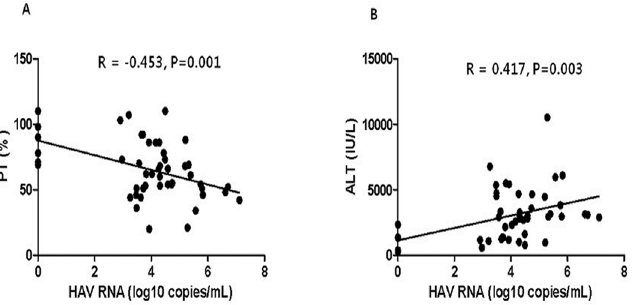
Fig 1. Viral load showed a significant inverse correlation with serum peak PT levels (A, r = -0.453, P = 0.001) and a significant direct correlation with serum peak ALT (B, r = 0.417, P =